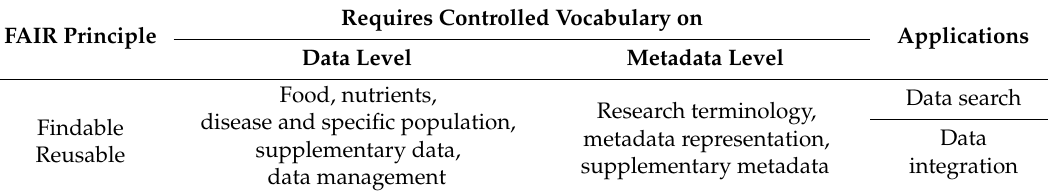
Table A1. Scope of controlled vocabulary in nutritional epidemiology to achieve the FAIR principle.